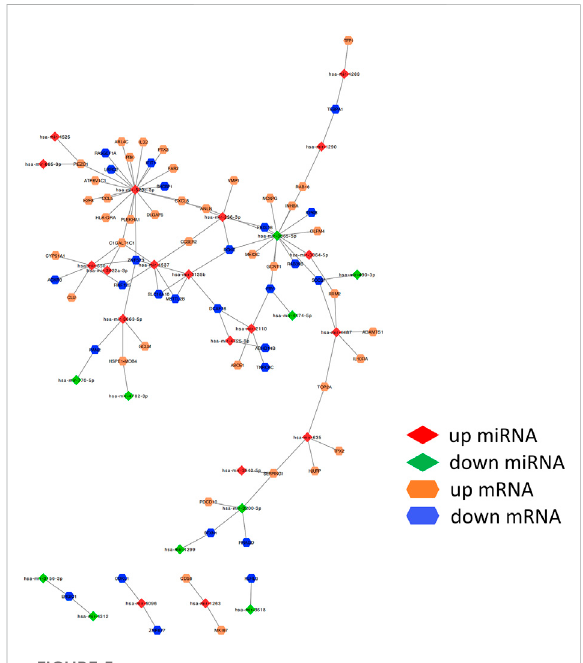
FIGURE 5 miRNA – mRNA regulatory relationships. ceRNA upregulated genes are yellow; downregulated genes are blue. The up- or down-regulated miRNA are highlighted in red and green, respectively. The edges represent miRNA – mRNA regulatory relationships.